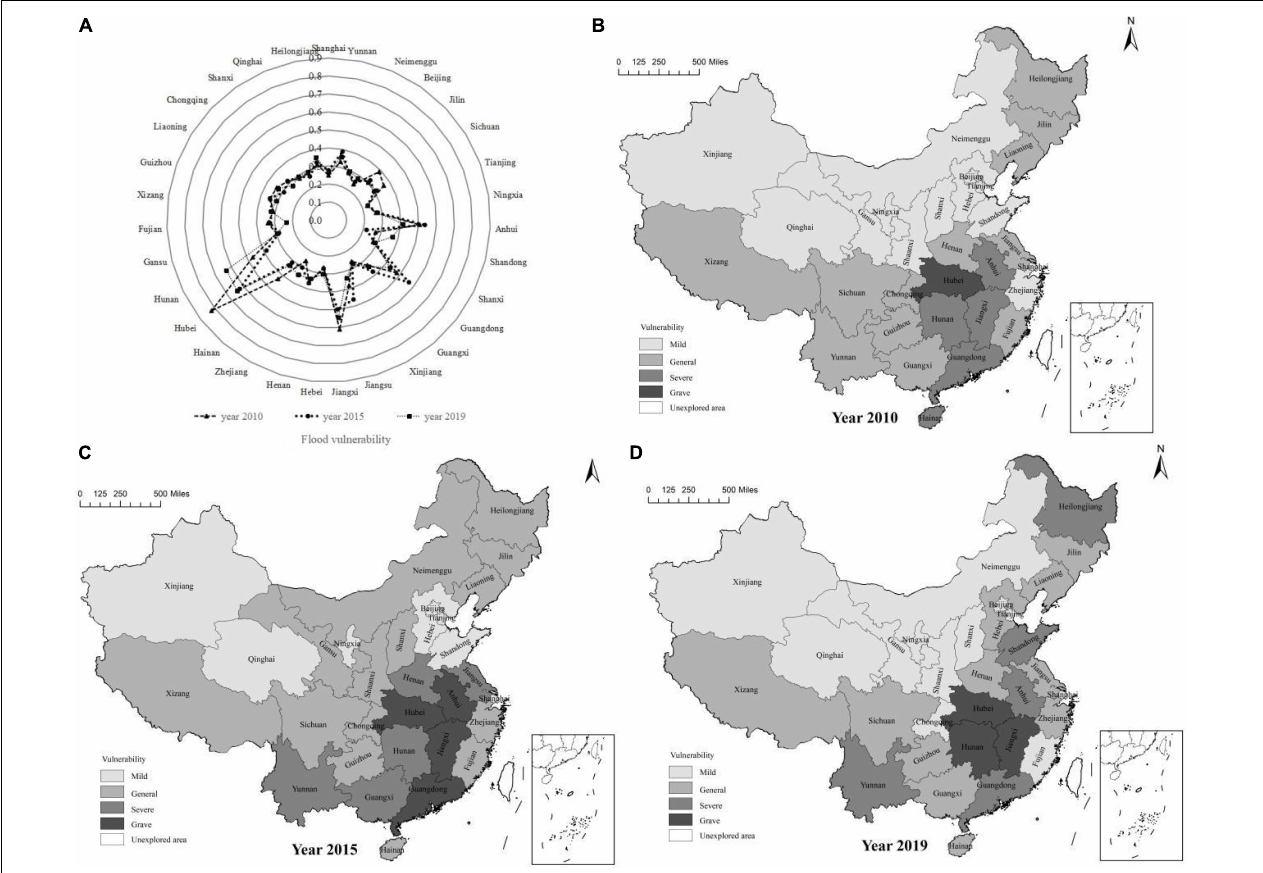
FIGURE 4 | Flood vulnerability assessment results and spatial distribution characteristics of inland fisheries in China from 2010 to 2019. Based on the standard map no. GS(2020)4619 of the standard map service website of the Ministry of Natural Resources, the base map is not modified. (A) Represents the radar diagram. (B) Represents the year 2010. (C) Represents the year 2015. (D) Represents the year